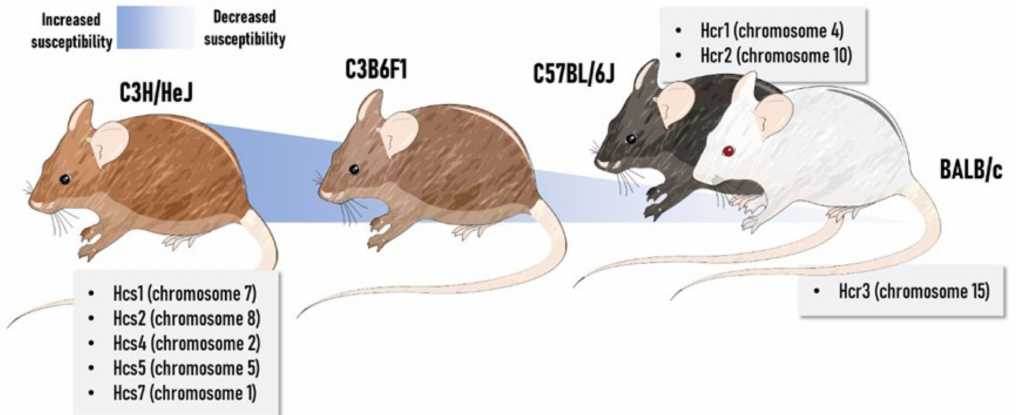
Figure 3. General depiction of some loci potentially involved in hepatocarcinogenesis susceptibility in widely-applied inbred and crossbred mouse strains. Hcs: Hepatocarcinogen susceptibility locus; Hcr: Hepatocarcinogen resistance locus. The figure was composed with the aid of illustrations from the SMART-servier Medical Art available at https://smart.servier.com/ (accessed on 15 January